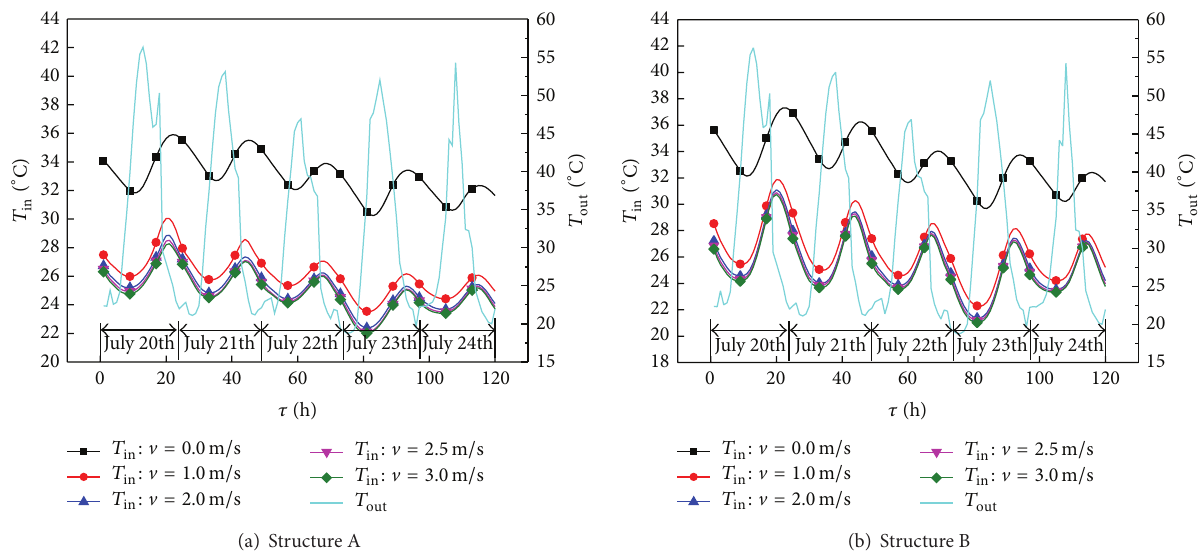
Figure 6: Contrast pictures of temperature of inner surface in different structure with several velocities.